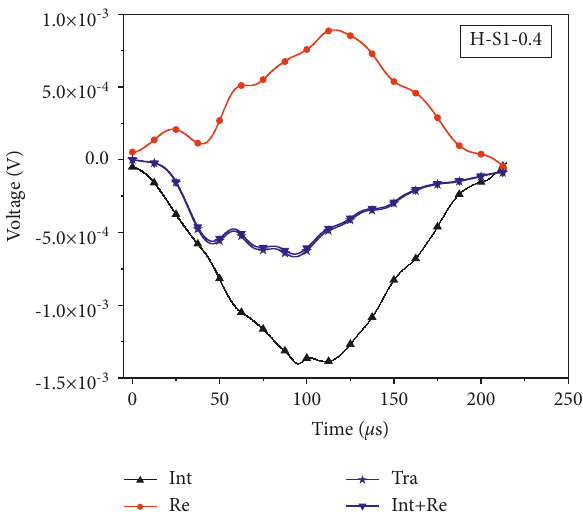
Figure 4: Dynamic stresses on both ends of the composite specimen.